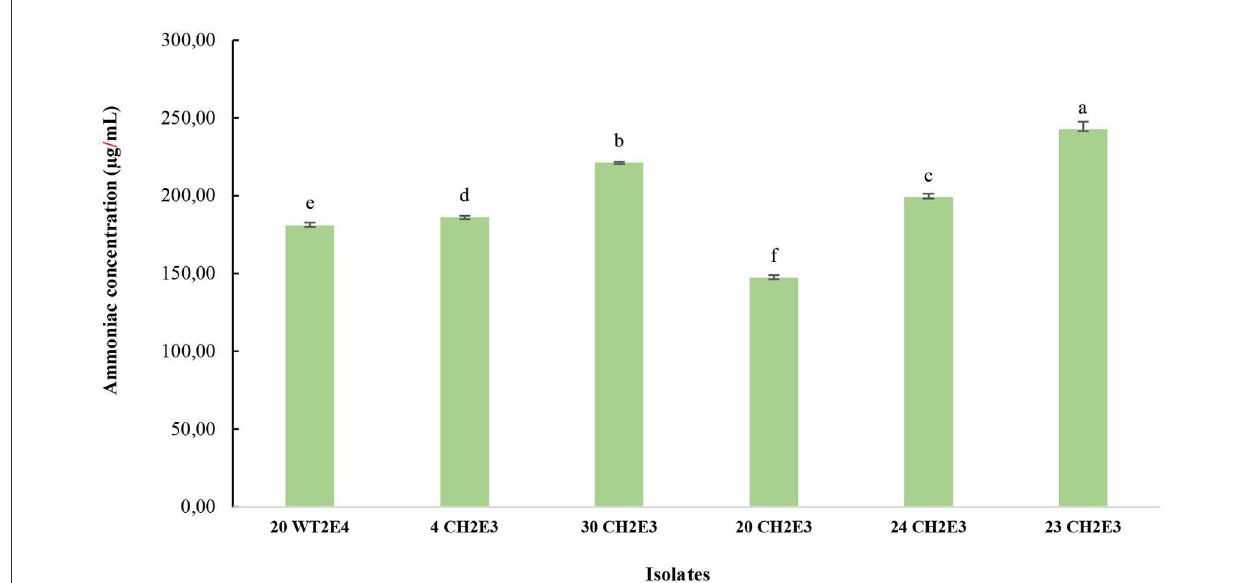
FIGURE6 Ammoniac production by the selected isolates for the quantitative test. Different letters indicate that values are statistically different at a P -value of ≤ 0.05.